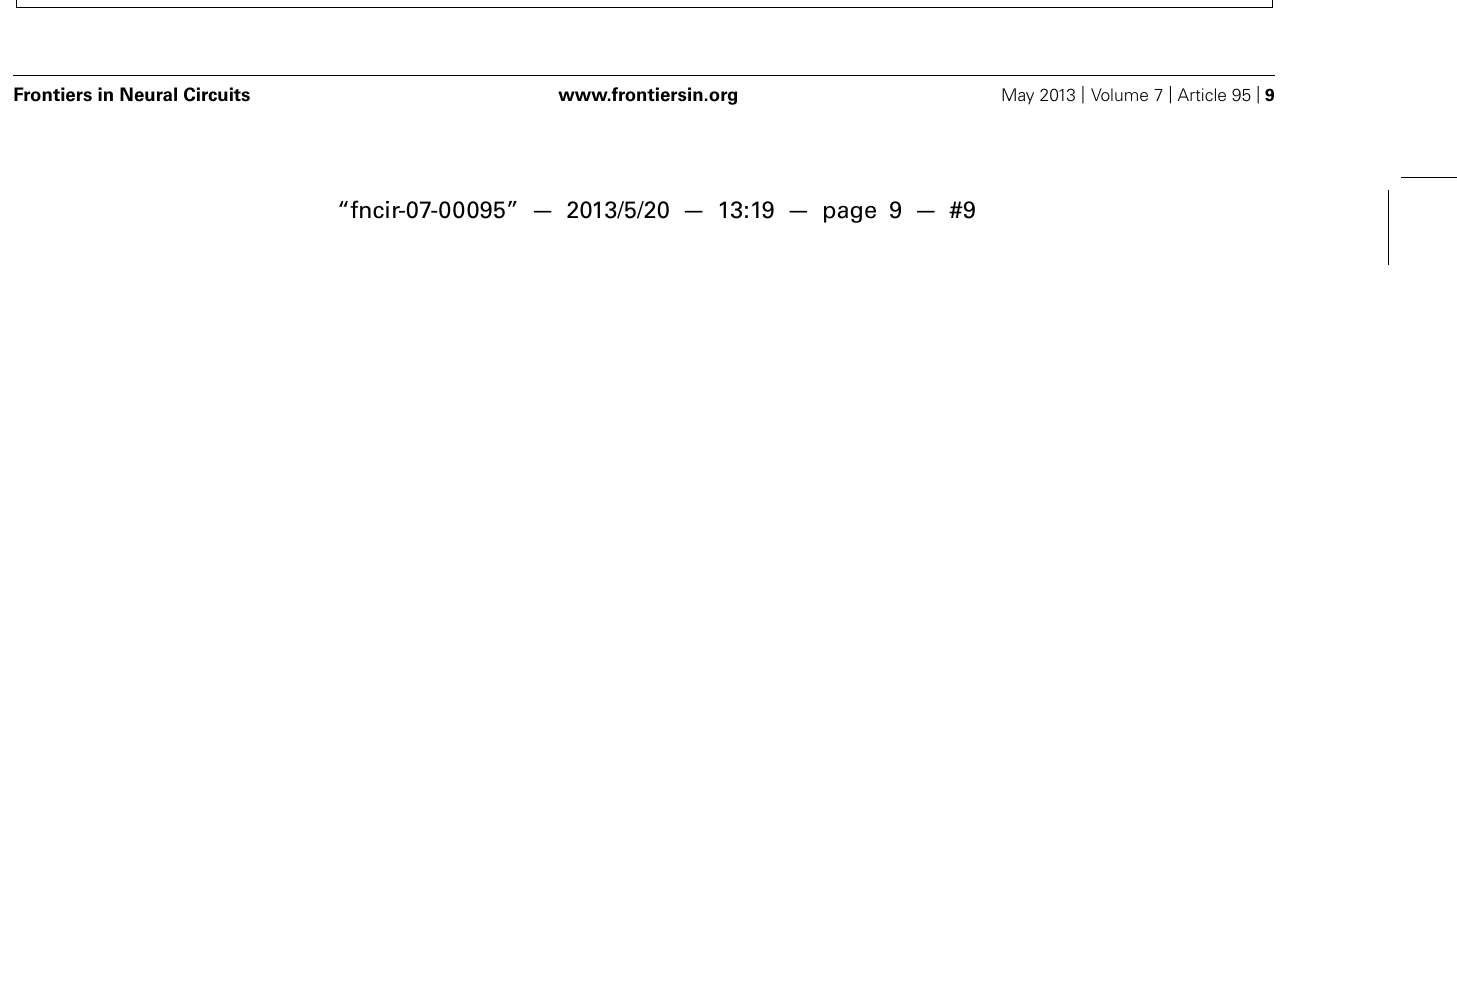
reluctant connections (purple, p > 0.05 for all comparisons). However, for responsive connections (green) EPSCs elicited by the 2nd, 3rd, and 6th spike were significantly larger than that by the 1st spike. No significant difference was observed between reluctant and responsive connections for EPSCs following the first spike. (D) Failure rate for all recorded pairs (gray), reluctant (purple), and responsive (green) connections. Responsive connections showed a short-lived facilitation for the 2nd and 3rd spike, resulting in a significantly smaller failure rate compared to reluctant connections ( p < 0.05; n = 8 and n = 4, respectively; one cell out of the 13 was ambiguous and not included in one of the two main categories). (E) Cumulative probability of release for all recorded pairs (gray), reluctant (purple), and responsive (green)